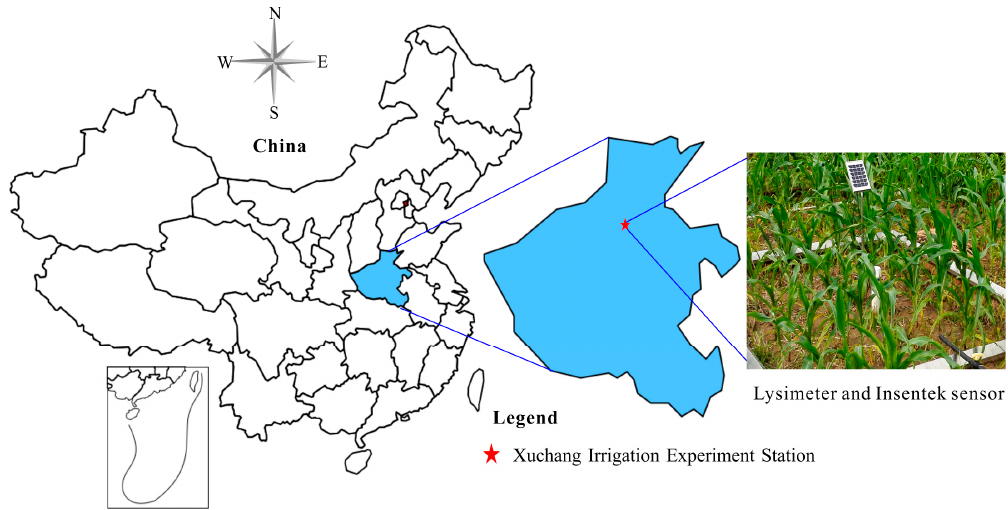
Figure 2. Schematic location of the Xuchang Irrigation Experiment Station and the lysimeter and Insentek sensor at the Station.